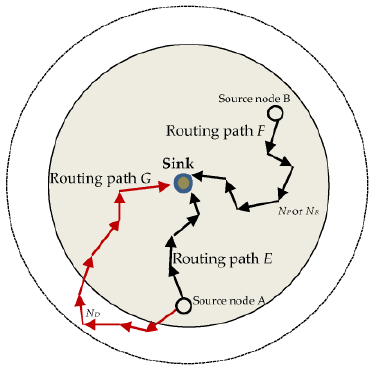
Figure 2. Routing paths for shortest path routing (path E ), phantom single-path routing, or directional random routing (path F ), and for the proposed routing scheme (path G ).